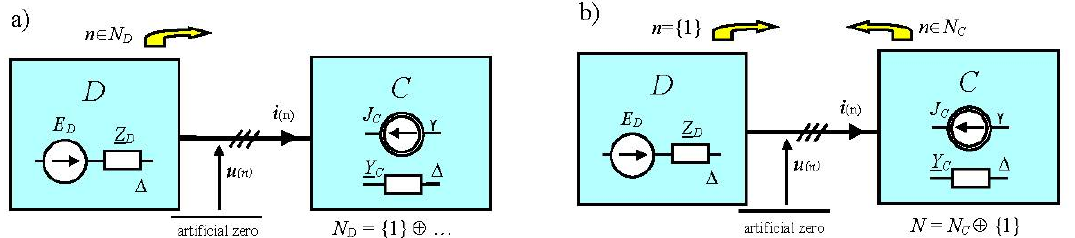
Figure 2. Block representation of the concept of energy flow between C and D systems, when: ( a ) n ∈ N D , ( b ) n ∈ N C .